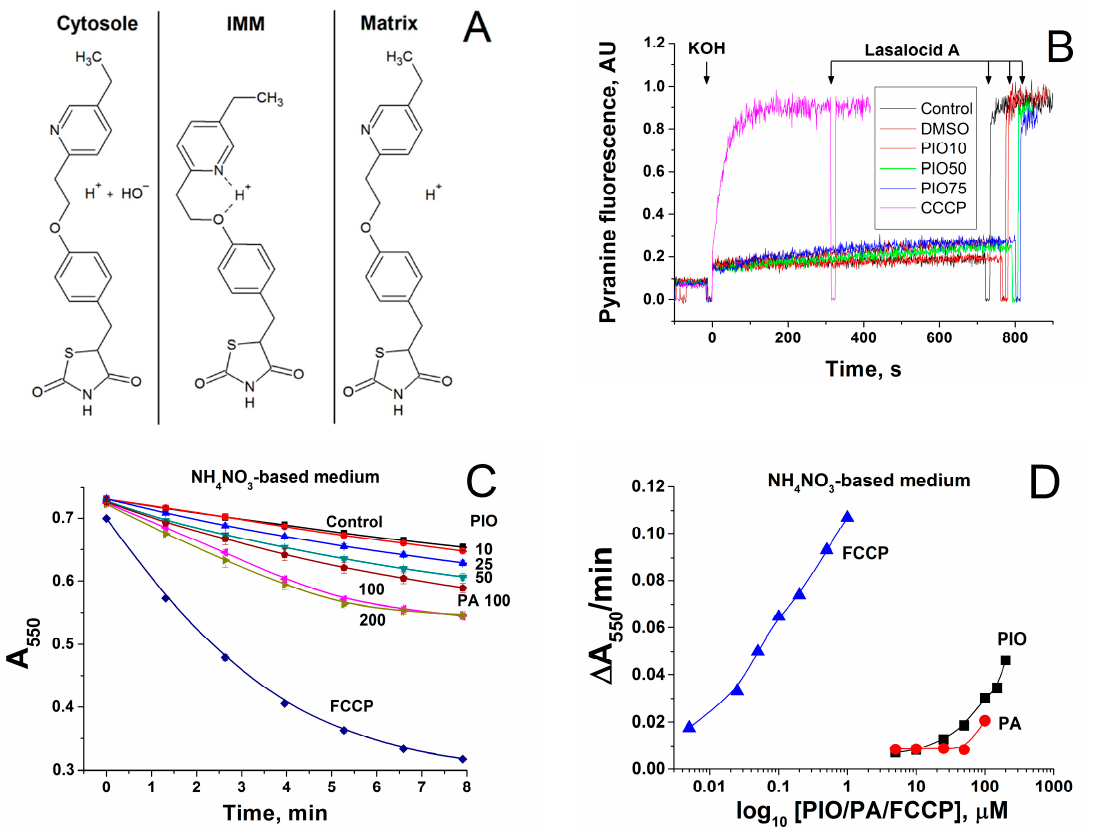
Figure 4. Mechanism of transmembrane proton transport by PIO. ( A ) Possible mechanism of proton transport by PIO across the IMM. ( B ) Comparison of CCCP- and PIO-mediated proton fluxes through liposomes loaded with the pH probe pyranine. The inner liposomal pH value was estimated from the pyranine fluorescence intensity measured at 505 nm upon excitation at 455 nm. Lasalocid A (1 µM) was added approximately at 800 s to equilibrate pH. PIO concentrations were 10 µM, red curve; 50 µM, green curve; 75 µM, blue curve. CCCP concentration was 1 µM (pink curve). Lipid concentration was 20 µg/mL, T = 15 °C. Other conditions: see Materials and Methods Section. The proton flux was initiated by an alkaline pH shift from рН 6 to рН 8, which was caused by the addition of the previously determined aliquot of KOH. In the presence of the protonophores, the pyranine fluorescence gradually increased, indicating the alignment of the pH values inside and outside liposomes due to proton transfer mediated by a protonophore. ( C , D ) Effect of PIO, palmitic acid, and FCCP on the swelling of deenergized mitochondria in NH 4 NO 3 -based medium. Mitochondria (0.75 mg prot./mL) were added to NH 4 NO 3 -based medium supplemented with rotenone (2.5 mg/mL), and 1 min later, the suspension was placed in the wells of a plate that contained PIO, sodium palmitate (PA), and FCCP at indicated concentrations. ( C ) Standard curves of mitochondrial swelling. ( D ) Initial rates of mitochondrial swelling during the first 3 min of incubation. Points are the means ± S.E.M. of three independent experiments ( n =